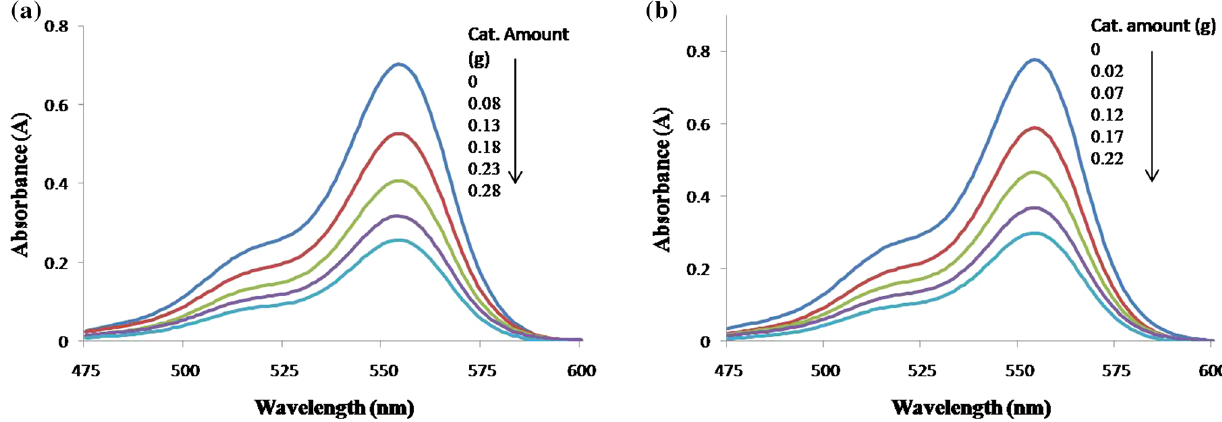
Fig. 9 UV–Vis spectra of RB dye under UV light irradiation at different amounts of a A-MWCNTs/Co–Ti oxides and b Co–Ti oxide NPs Fig. 10 %Degradation comparison of RB dye by different amounts of A-MWCNTs/Co–Ti oxides and Co–Ti oxide